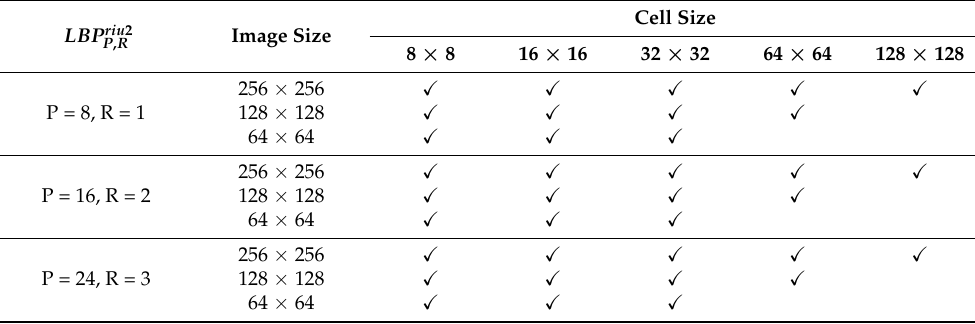
Table 2. Configuration of experimental dataset for texture feature